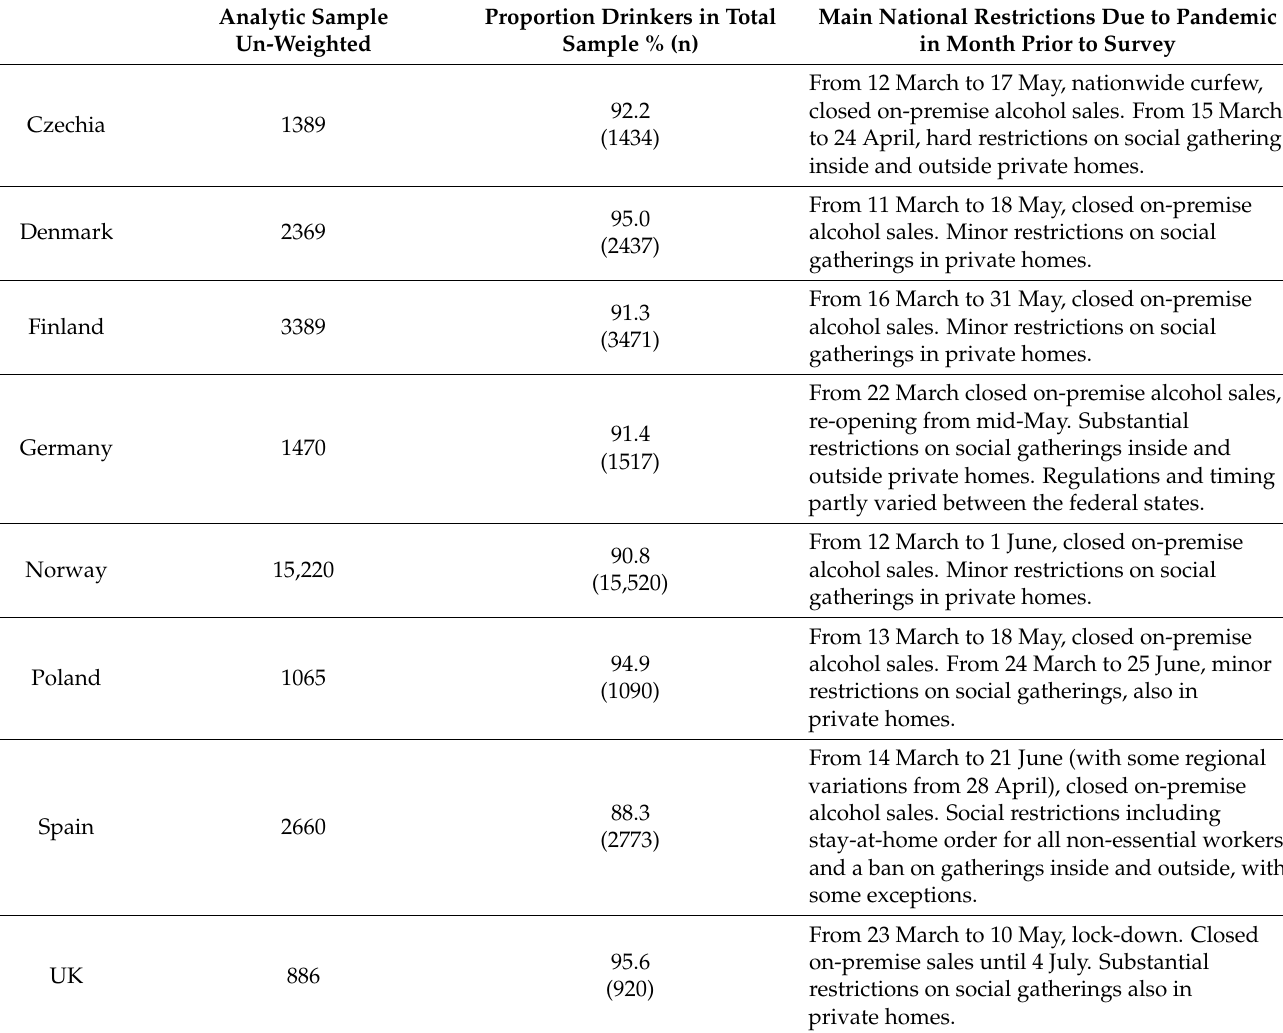
Table 1. Analytic sample size, proportion of drinkers in total sample and main national pandemic-related restrictions relevant for alcohol consumption in the first phase of the pandemic, by